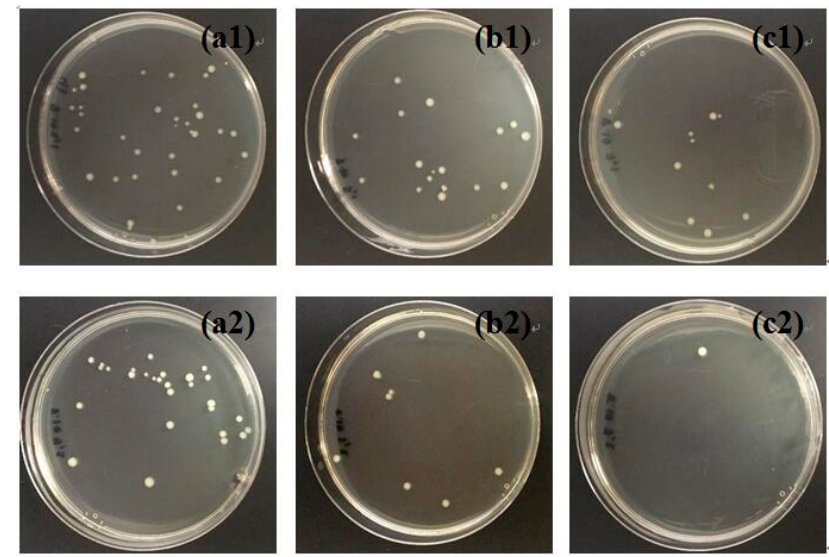
Figure 9. Antibacterial results under the dark condition for Ag/TiO 2 /cellulose composite films with Ag/TiO 2 molar ratios of ( a1 ) 0.2%; ( b1 ) 1.0%; and ( c1 ) 5.0%. Antibacterial results under the UV condition for Ag/TiO 2 /cellulose composite films with Ag/TiO 2 molar ratios of ( a2 ) 0.2%; ( b2 ) 1.0%; and ( c2 ) 5.0%.